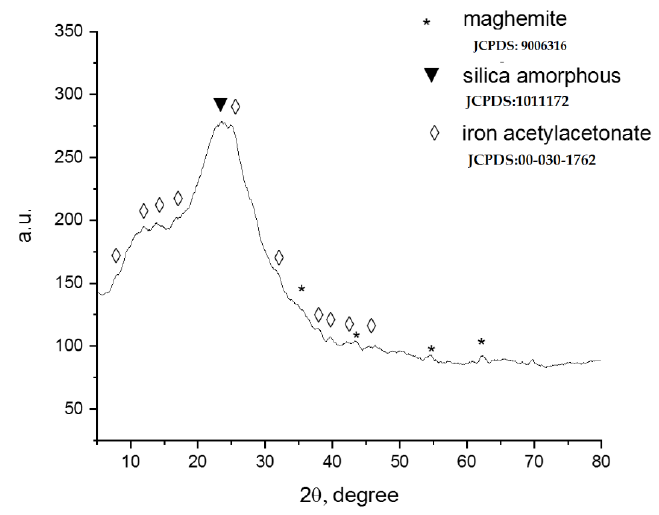
Figure 2. X-ray Figure 2. X-ray diffraction.